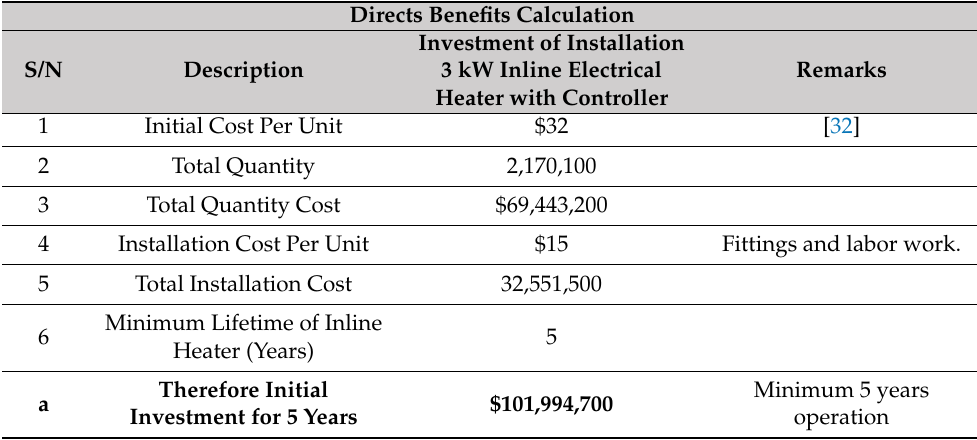
Table 5. Summary of direct and indirect benefits’ techno-economy